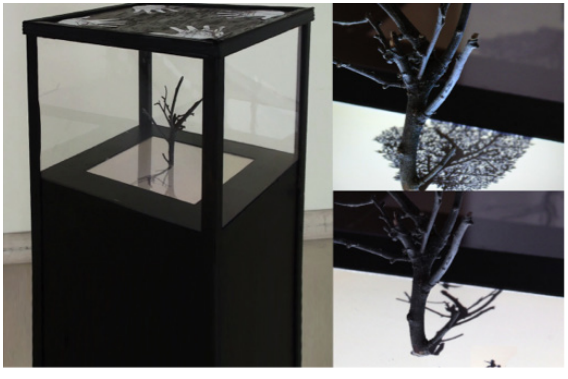
FIGURE 1 | Display of The Memory of a Tree.